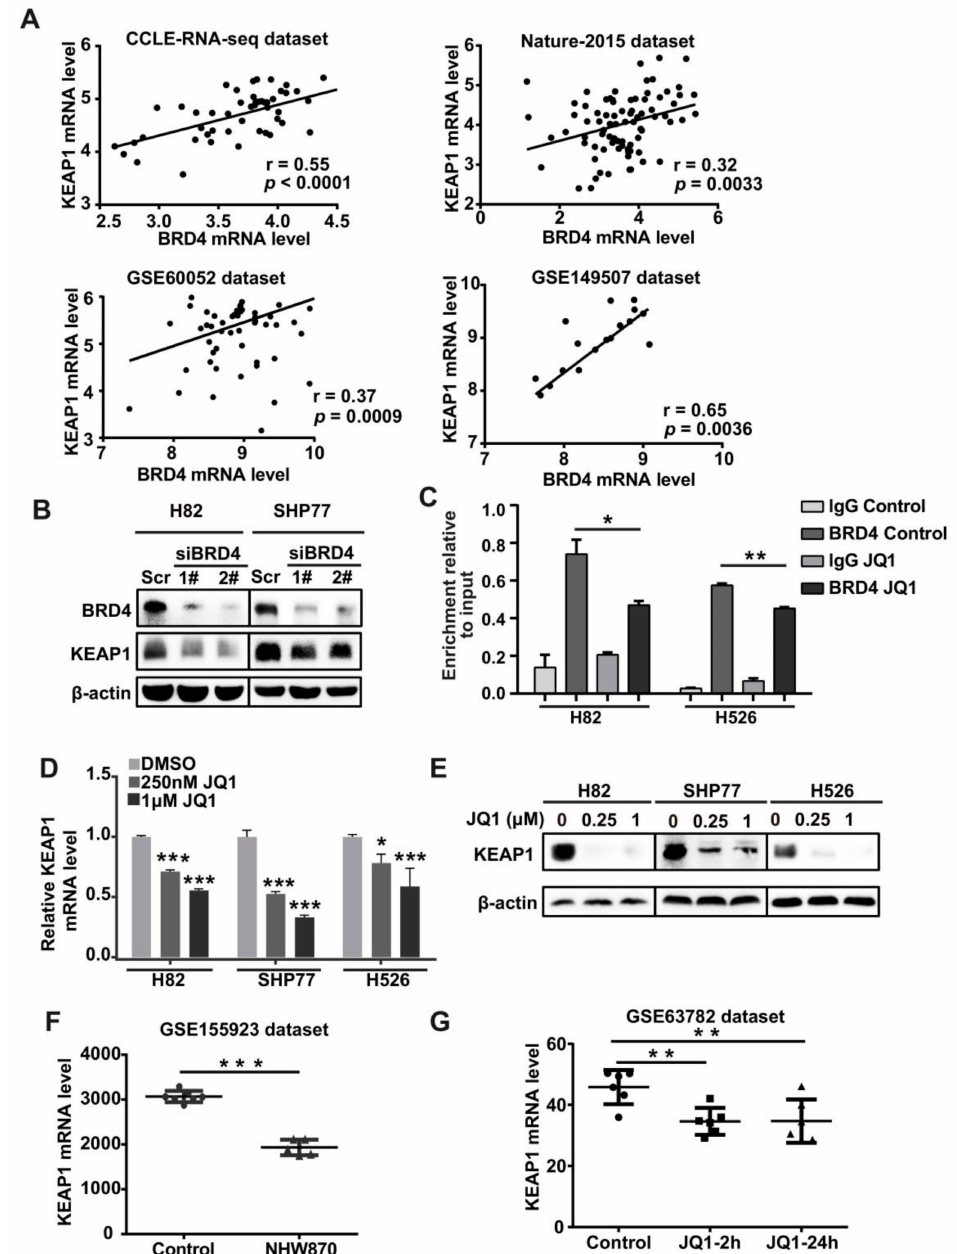
Figure 3. BRD4 targets the KEAP1 promoter and dominantly regulates KEAP1 expression. ( A ) Scatter plot showing the correlation between KEAP1 and BRD4 RNA expression that was demonstrated based on the four databases. ( B ) Western blot analysis of BRD4 and KEAP1 upon knockdown of BRD4 in SCLC cells. ( C ) ChIP-qRT-PCR experiment indicating the direct binding of BRD4 to the KEAP1 promoter in H82 and H526 cells after 48-h exposure to JQ1 or 0.01% DMSO (vehicle). The effect of JQ1 on the DNA-binding efficiency of BRD4 to the KEAP1 promoter was observed. ( D , E ) The effect of JQ1 on the KEAP1 expression by RT-qPCR ( D ) or western blot ( E ) in H82, SHP77, and H526 cells. ( F , G ) Scatter plots showing KEAP1 expression on BET inhibitor NHW870 ( F ) or JQ1 ( G ) based on the GSE155923 and GSE63782 datasets. * p < 0.05; ** p < 0.01; *** p < 0.001 (Student’s t